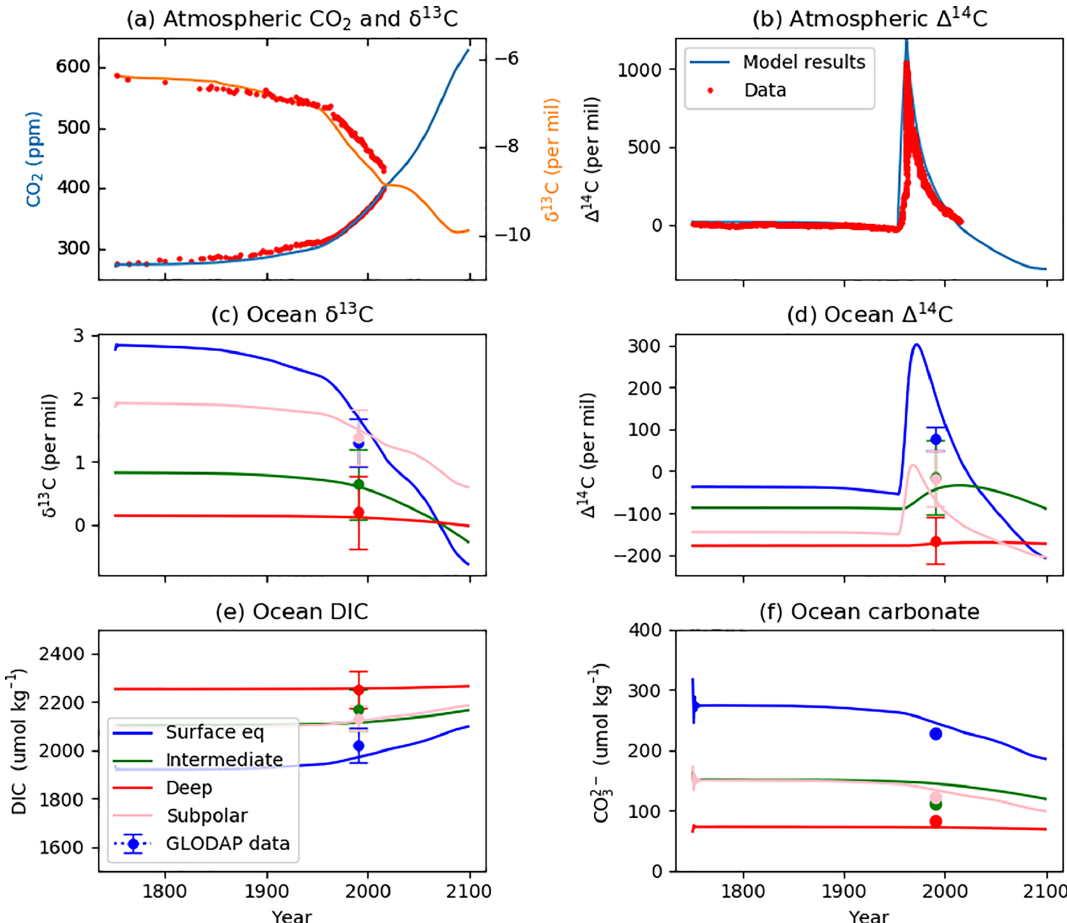
Figure 5. SCP-M modelling results compared with modern atmospheric and ocean GLODAPv2 data for (a) atmospheric CO 2 and δ 13 C, (b) atmospheric (cid:49) 14 C, (c) ocean δ 13 C, (d) (cid:49) 14 C, (e) DIC, and (f) the carbonate ion proxy. Projections beyond 2016 include the RCP6.0 emissions trajectory. In (a–b) we plot SCP-M model results for CO 2 , δ 13 C and (cid:49) 14 C (lines) for the period 1751–2100 against atmospheric data for CO 2 , δ 13 C and (cid:49) 14 C (red dots). The SCP-M model output closely resembles the atmospheric data record. The perturbation from industrial-era, isotopically depleted ( δ 13 C) and dead ( (cid:49) 14 C) CO 2 is clear, as is the impact of atmospheric nuclear tests on (cid:49) 14 C during 1954–1963. In the other rows we plot SCP-M model results (boxes as shown) versus GLODAPv2 data (dots and error bars, same colour as corresponding boxes). We assume an average data year of 1990 for the GLODAPv2 data accumulated over the period 1972–2013. For most of the SCP-M ocean boxes, the model results fall within or very close to error ranges of the GLODAPv2 data, despite large perturbations in the model and data from industrial-era emissions and bomb